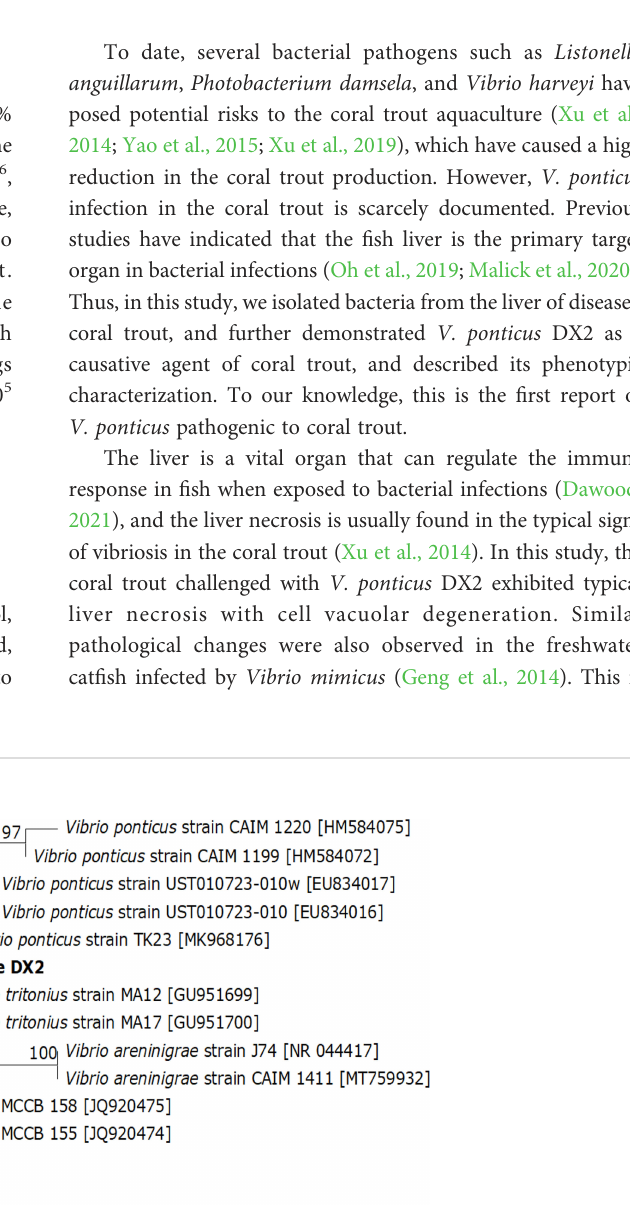
FIGURE 3 Neighbor-joining phylogenetic tree based on the 16S rRNA gene sequences of the DX2 isolate and 11 known bacteria. The GenBank accession numbers are shown beside the strain names, bootstrap values (%) are indicated beside the clades, and scale bars represent distance